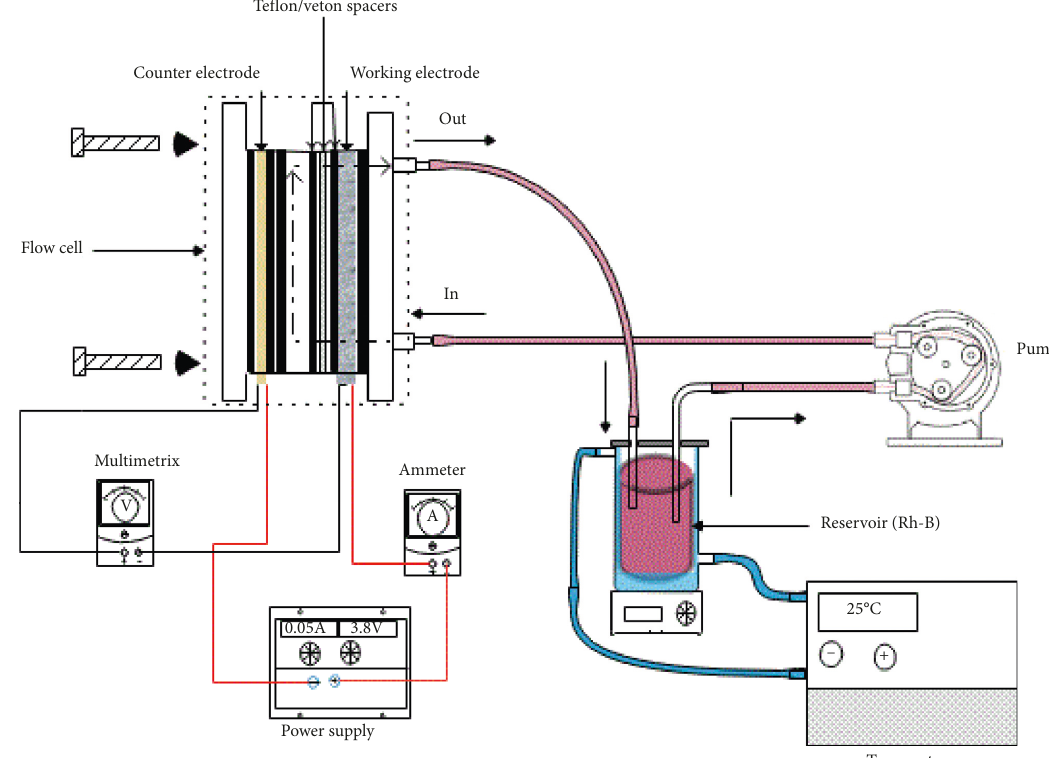
Figure 2: Experimental setup of the treatment